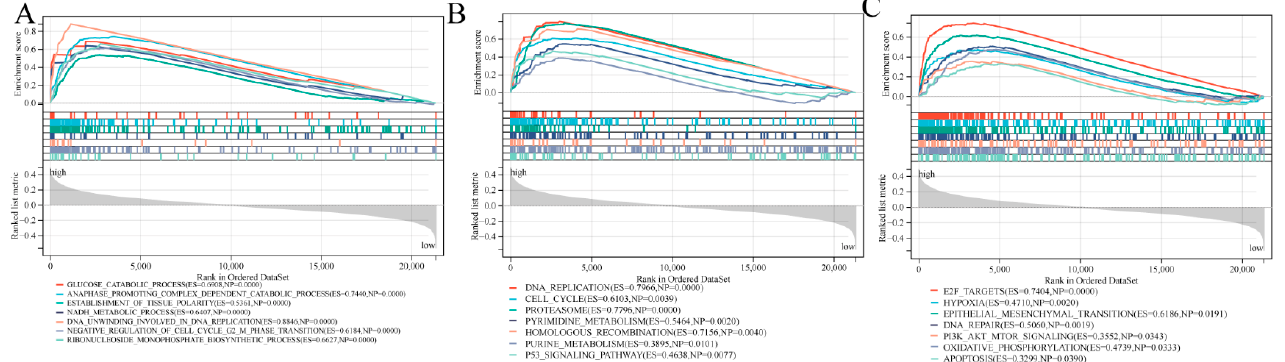
Figure 7. GSEA on biological roles as well as pathways. ( A ) GO analysis. ( B ) KEGG analysis. ( C ) Hallmark gene set.